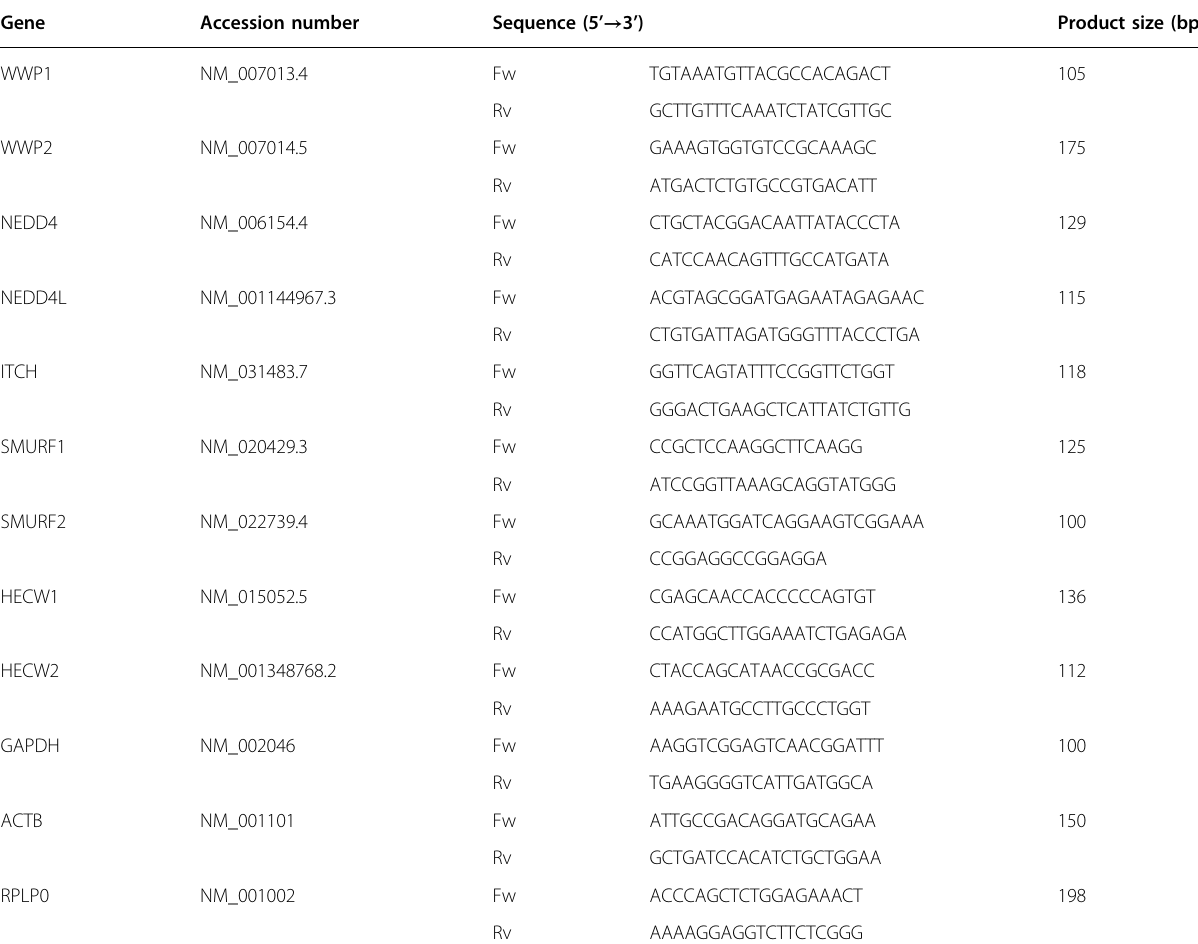
Table 2 Real-Time PCR primer